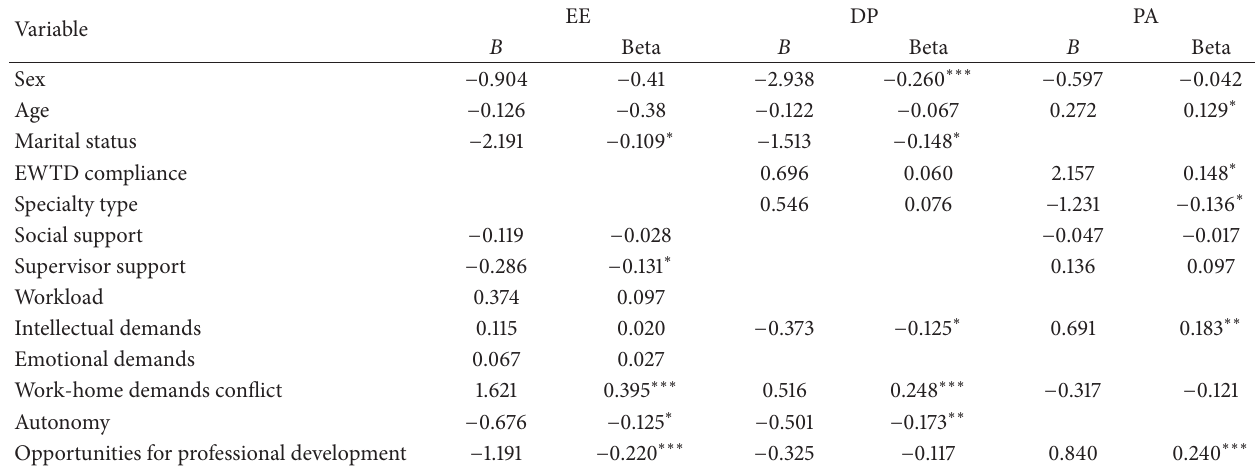
Table 5: General linear model analysis of the factors associated with burnout dimensions’